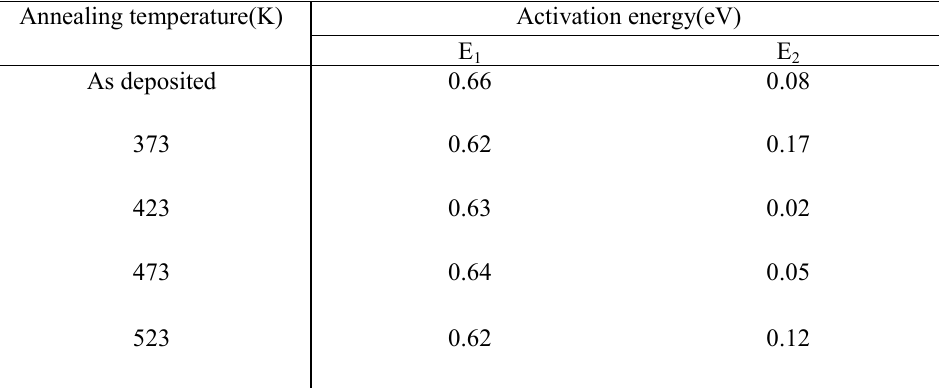
Table 2. Activation energies of ZnTTBPc thin